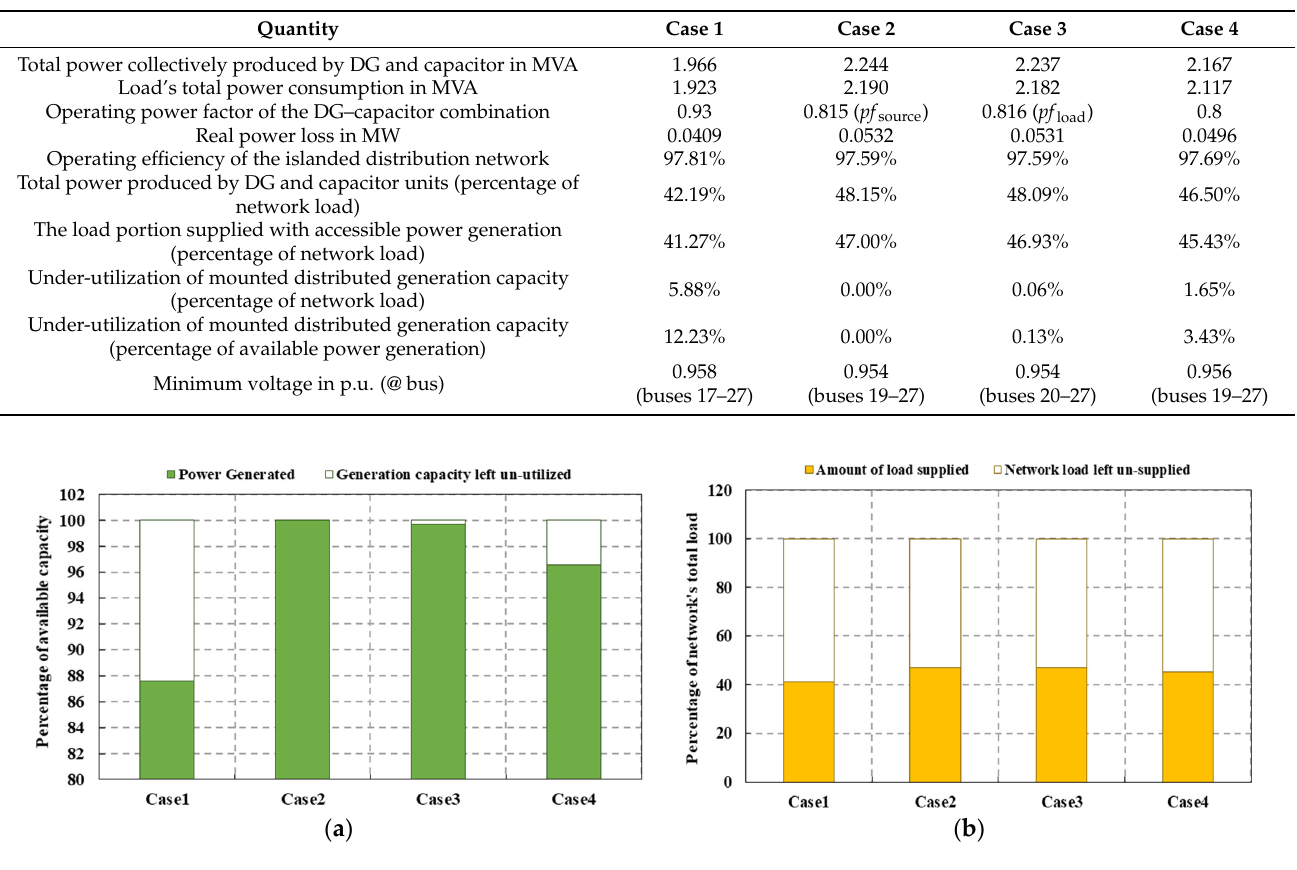
Figure 11. Performance comparison of the 69-bus autonomous distribution network at different pfsource. ( a ) Installed power generation capacity’s percent utilization. ( b ) Network’s percent load share delivered with accessible power.